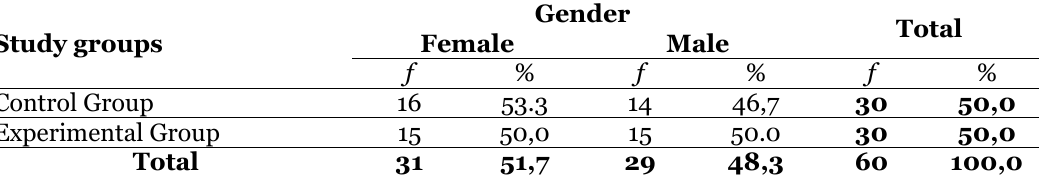
Gender Distribution of the Study Group